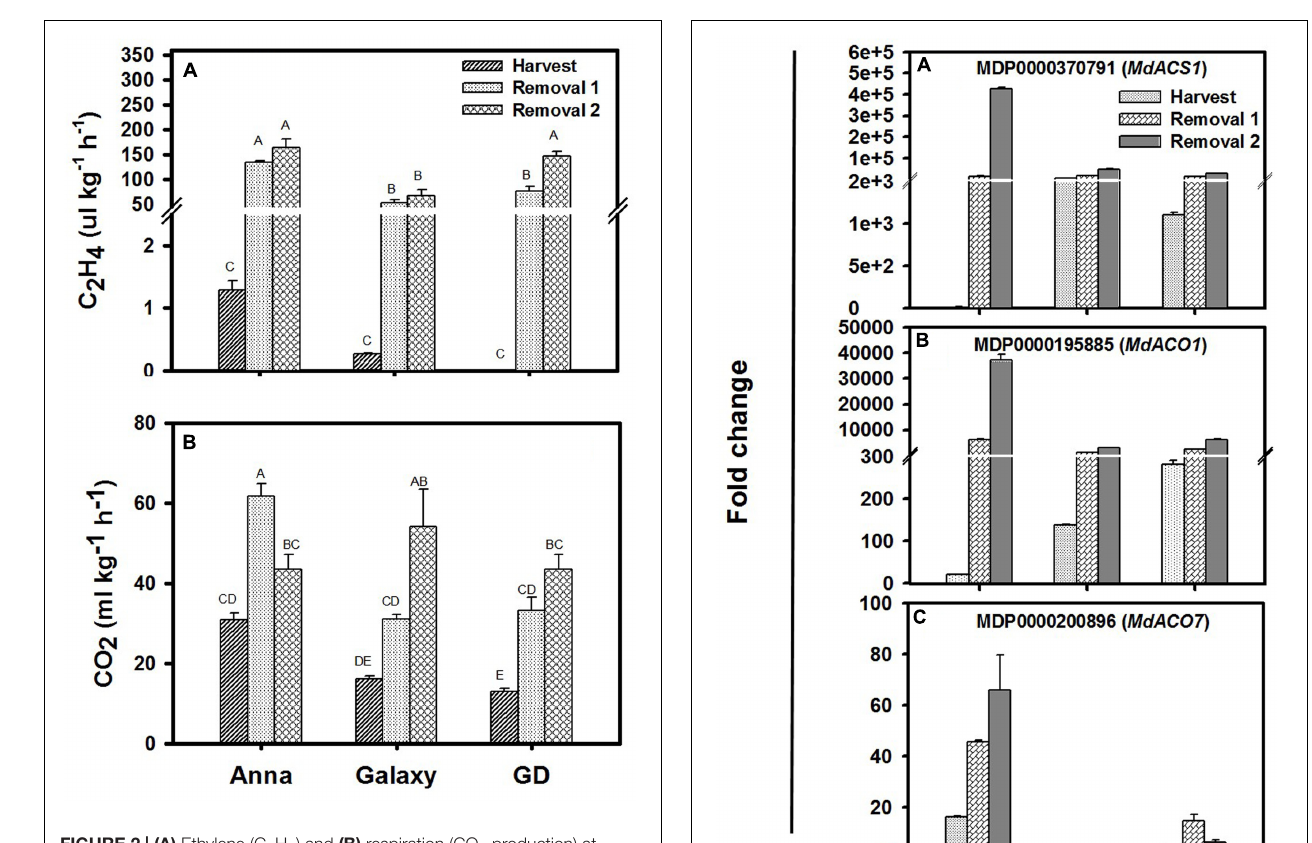
FIGURE 2 | (A) Ethylene (C 2 H 4 ) and (B) respiration (CO 2 production) at harvest and storage (R1–R2). Each value represents the mean of 10 fruit and vertical bars indicate ± SE. Significance analysis was performed by comparing all cultivars and their stages collectively, using Tukey’s HSD pairwise comparison tests at p ≤ 0.05. Unlike letters represent significantly different groups.